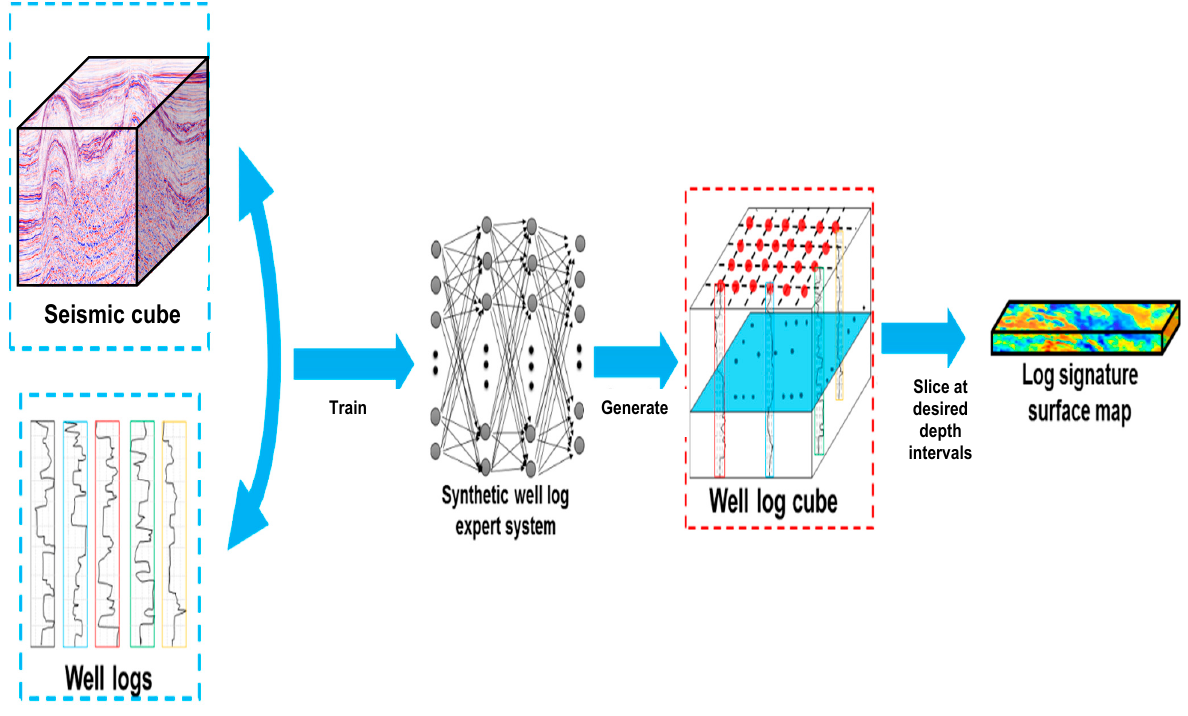
Figure 13. Schematic representation of the workflow for the first tool.